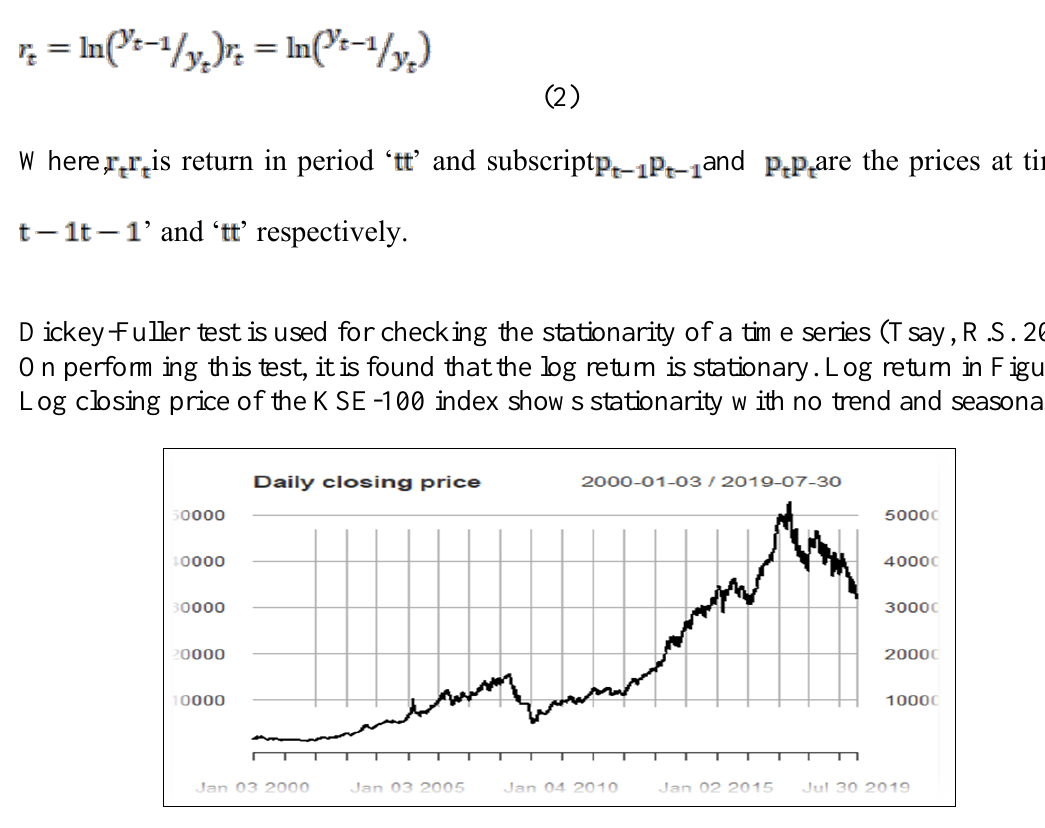
Figure.1. Daily Closing Price of KSE-100 Index from January 2000 to July 2019 Source: Daily closing price collected from yahoo